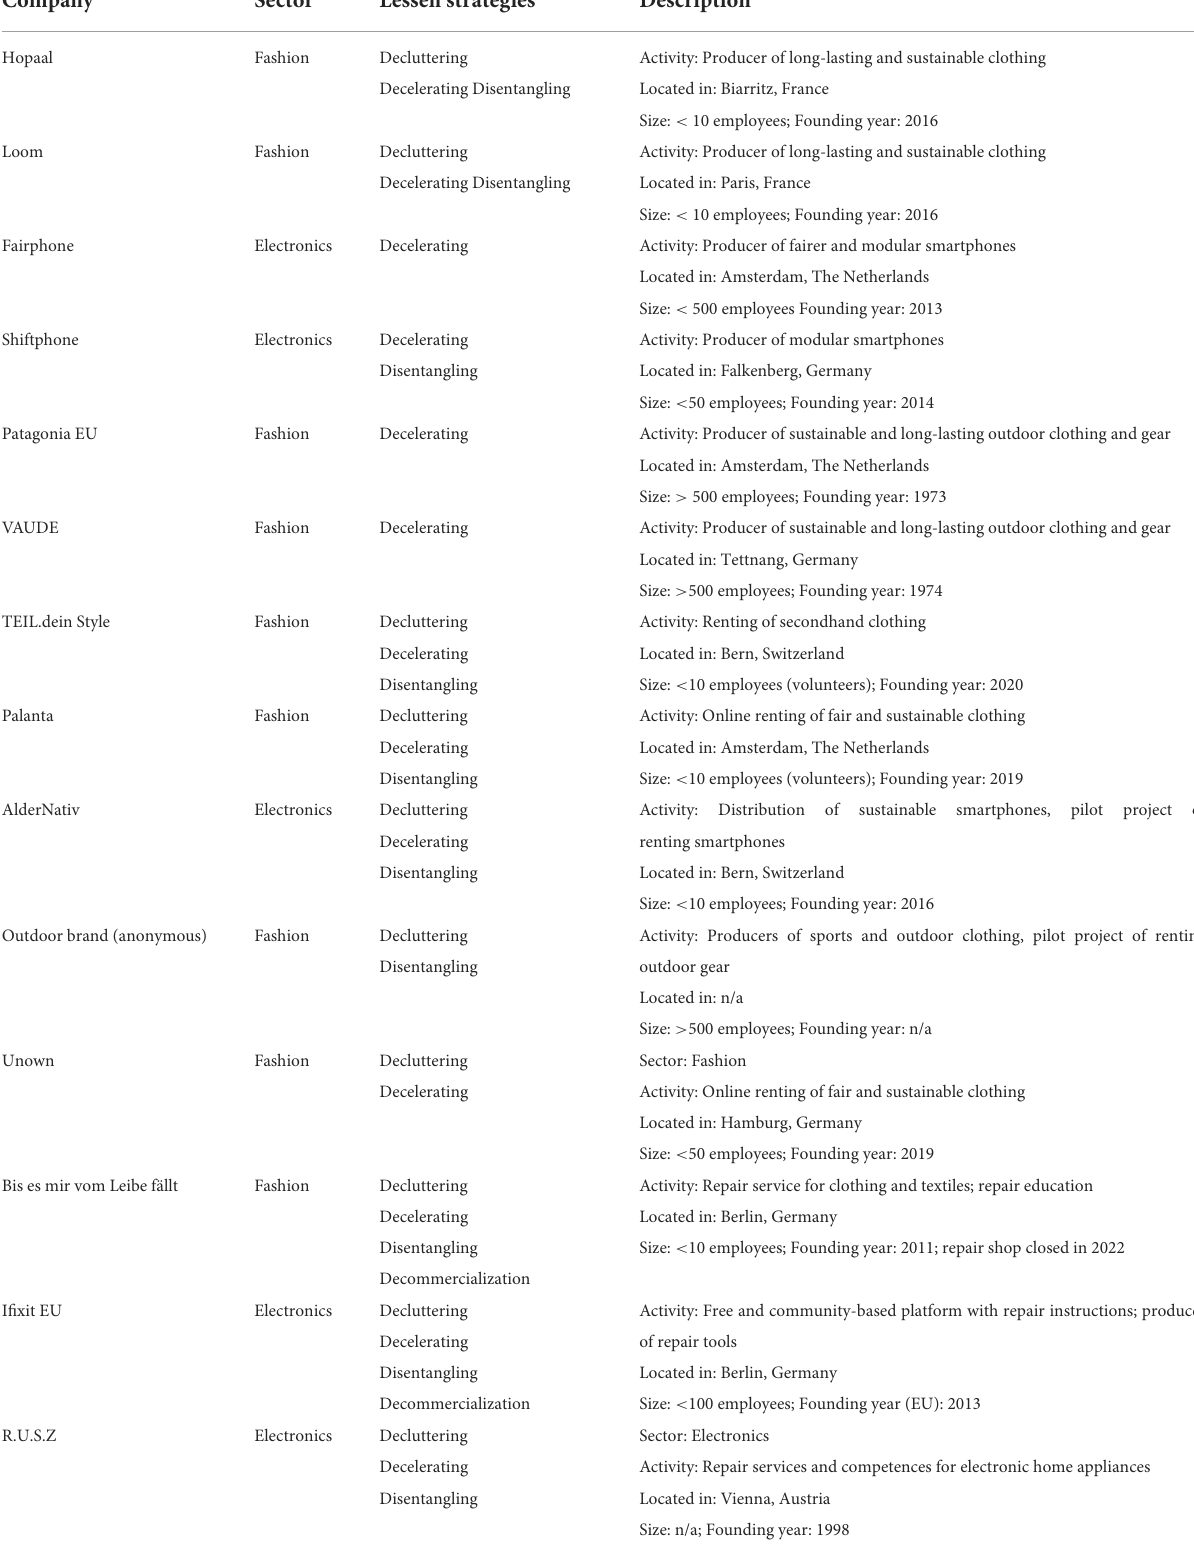
TABLE 2 List of sufficiency-oriented business cases from the study.